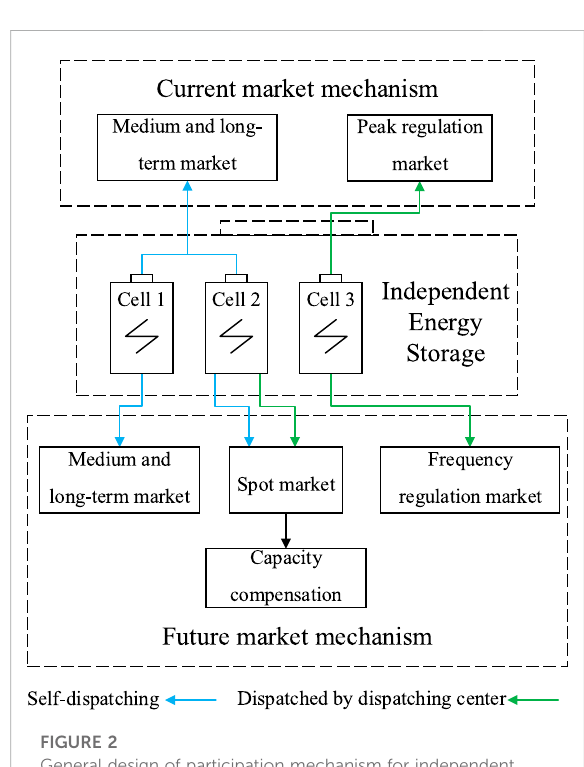
FIGURE 2 General design of participation mechanism for independent energy storage in the